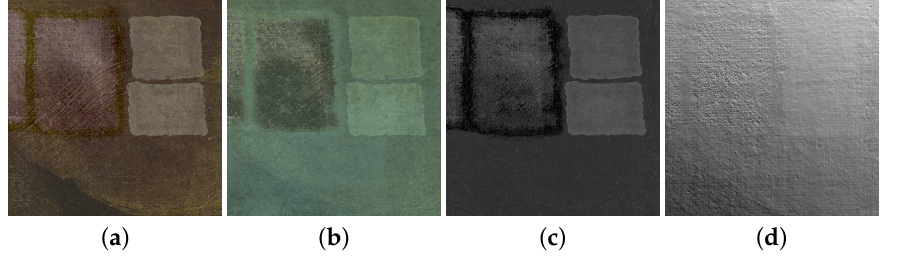
Figure 12. Technical photography on Tintoretto detail (experiment 1): ( a ) VIS. ( b ) UV-induced VIS fluorescence. ( c ) UV reflected. ( d )